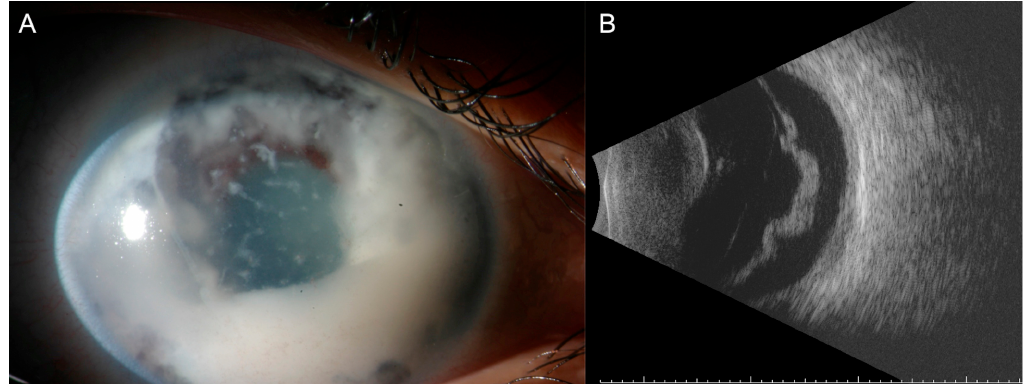
Figure 3. A case of post enucleation histologically proven diffuse retinoblastoma in an 8-year old child. Note ( A ) the anterior chamber invasion and ( B ) the increase retinal thickness of the detached retina in the B-Scan examination. ( B ) No calcifications are detectable by ultrasound.